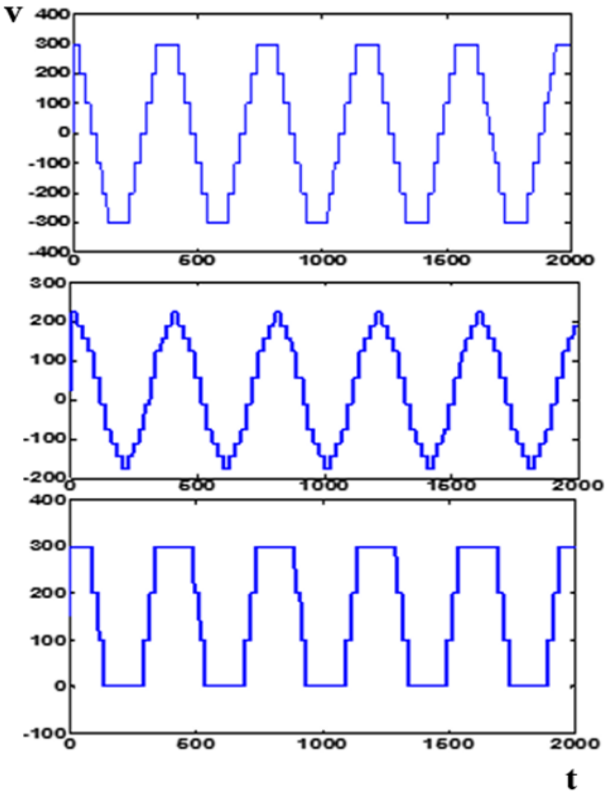
Figure 7. Simulated results for T-NPP. From top to bottom: output line voltage, the line to neutral voltage, and line to ground voltage.